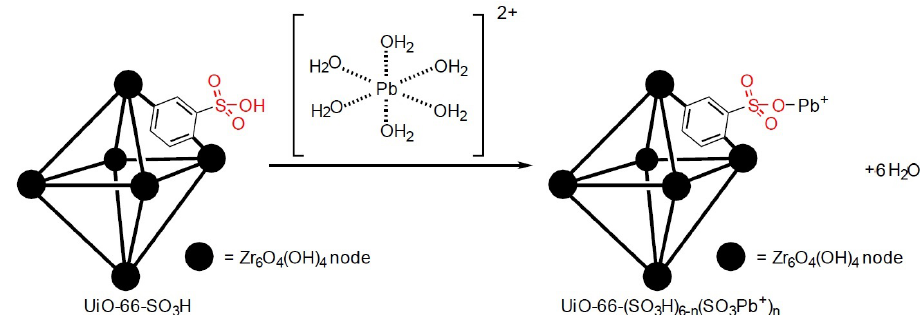
Figure 4. Diagram of adsorption of [Pb(OH 2 ) 6 ] 2 + on SO 3 H-UiO-66(Zr) in